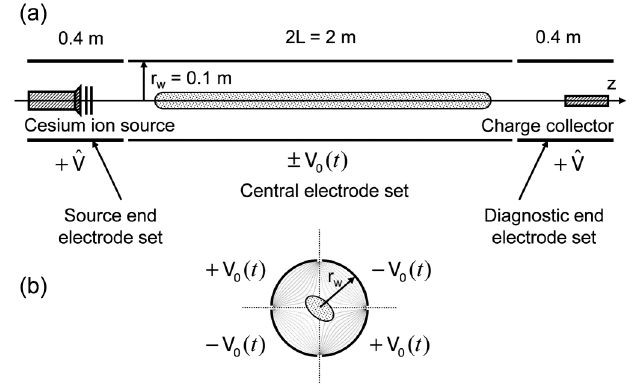
FIG. 1. Schematic of the PTSX device showing: (a) side view of the quadrupole electrodes, cesium ion source, and charge collector, and (b) end view of the central electrode